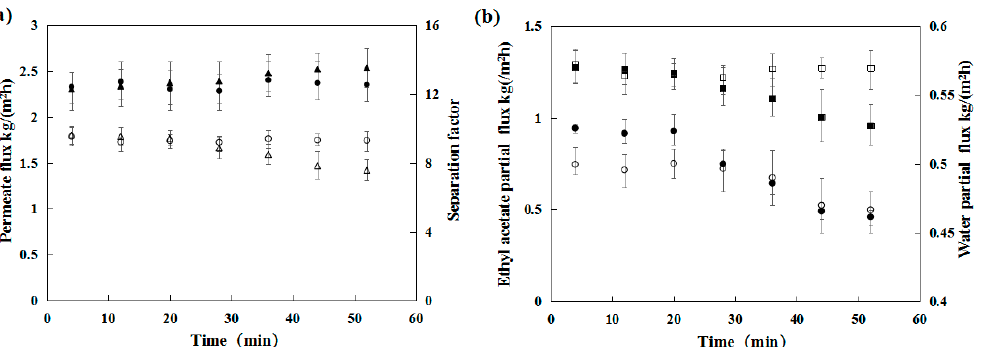
Figure 4. ( a ) Influence of NaCl and operation time on the pervaporation performance in the water– ethyl acetate–NaCl ternary system. ( △ ) Permeate flux (kg/m 2 h) for 15 wt.% NaCl concentration; ( ▲ ) Separation factor for 15 wt.% NaCl concentration; ( ○ ) Permeate flux (kg/m 2 h) for 0 wt.% NaCl concentration: ( ● ) Separation factor for 0 wt.% NaCl concentration; ( b ) Partial flux of Ethyl acetate and water; ( ● ) Water flux (kg/m 2 h) for 15 wt.% NaCl concentration; ( ○ ) Water flux (kg/m 2 h) for 0 wt.% NaCl concentration; ( ■ ) Ethyl acetate flux (kg/m 2 h) for 15 wt.% NaCl concentration; ( □ ) Ethyl acetate flux (kg/m 2 h) for 0 wt.% NaCl concentration.